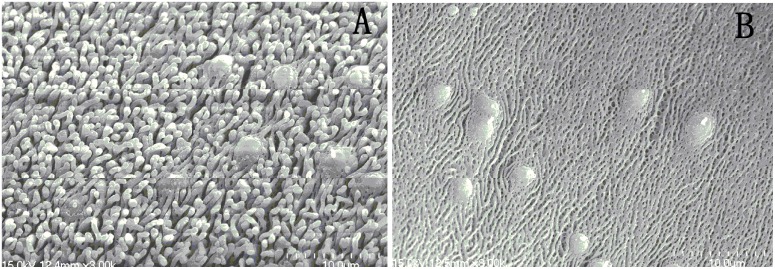
Scanning electron microscopy (SEM, ×3000) observation on the tegument of male adult Schistosoma japonicum harbored in control mice.A: tegumental ridges and sensory structures along dorsal (or ventral) part in mid-portion of the worm body (×3000); B: The tegument in the inner wall of the worm gynecophoral canal (×3000).